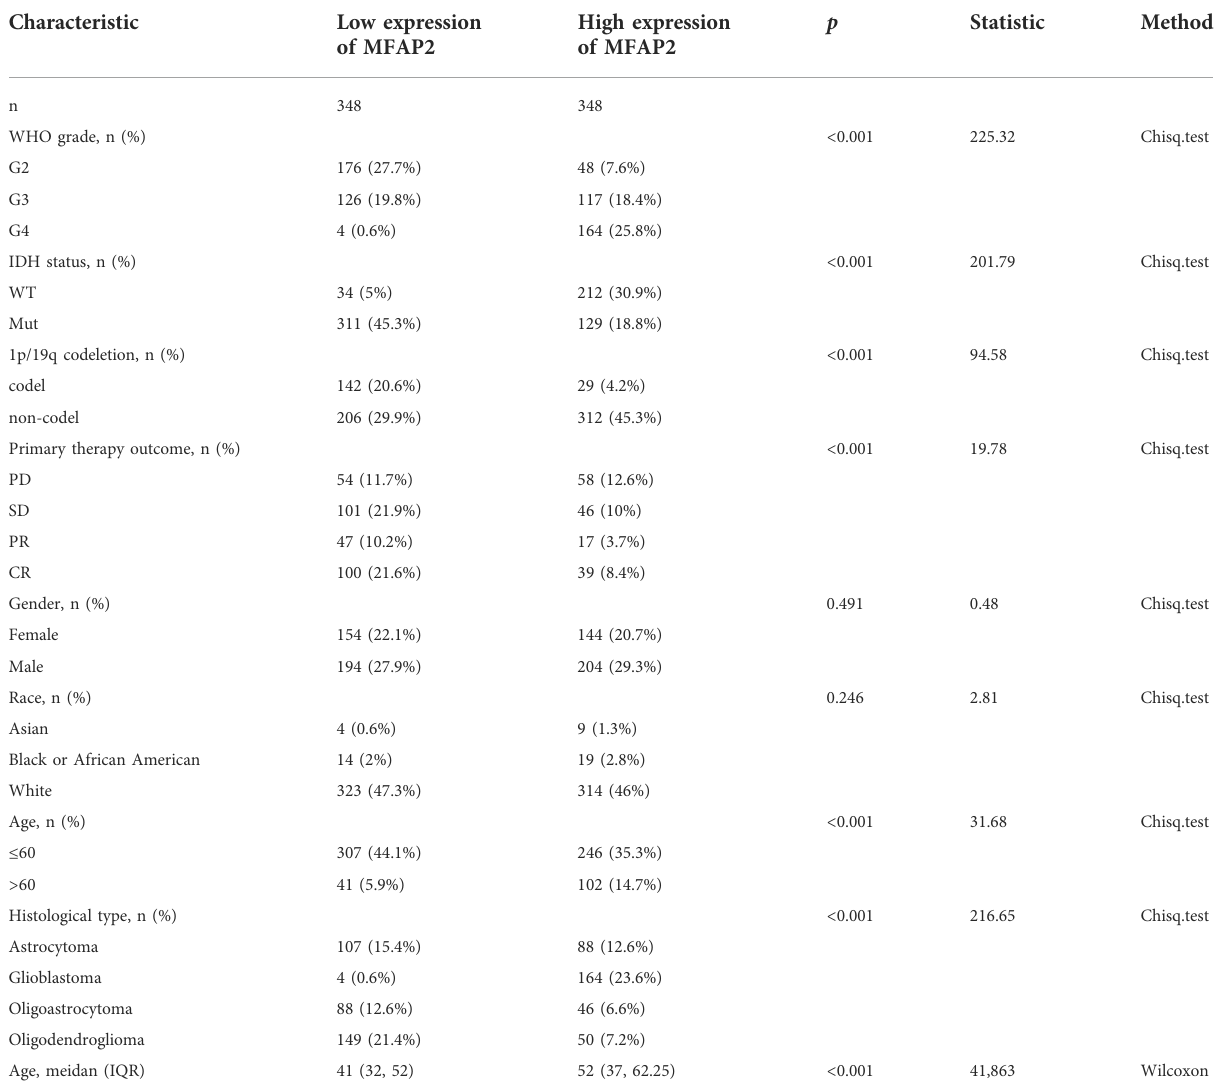
TABLE 1 The characteristics of patients with glioma based on